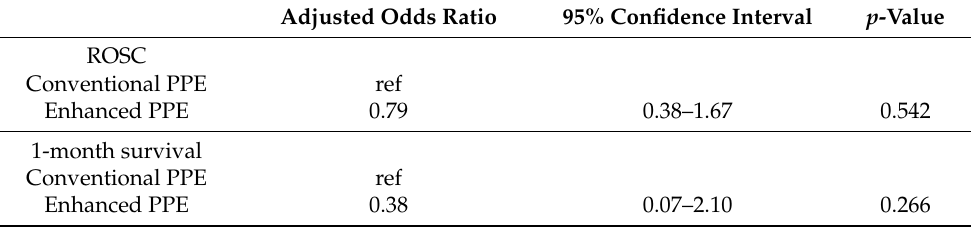
Table 2. Association between clinical outcomes and enhanced personal protective